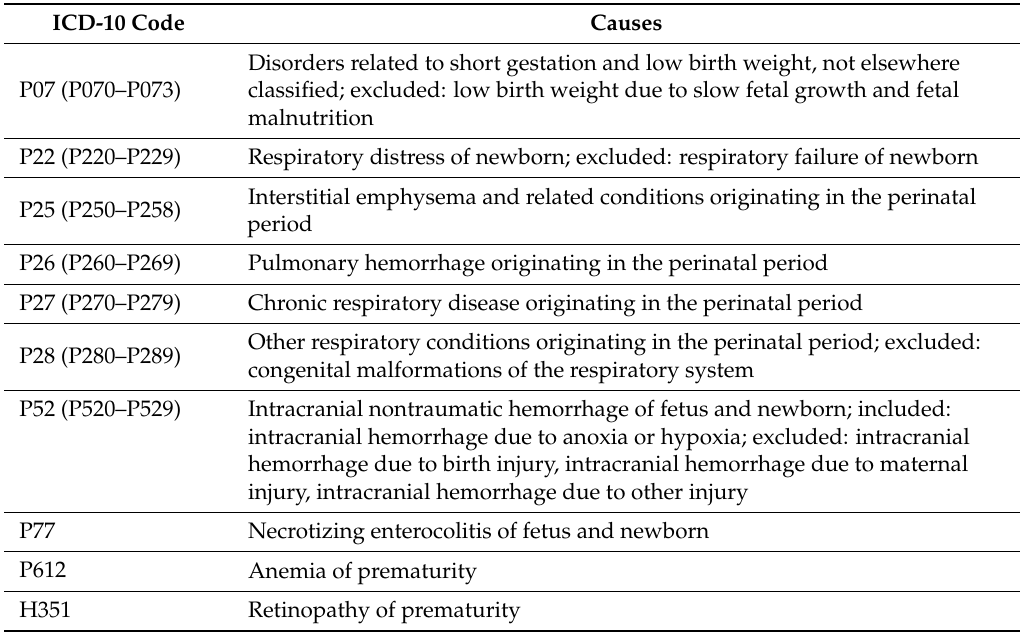
Table 1. Operational definitions of preterm birth